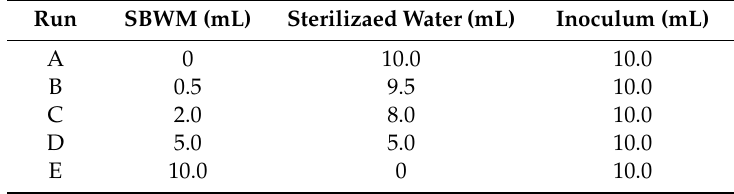
Table 1. Composition of batch cultures